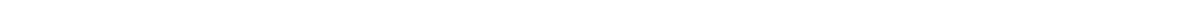
Fig. 4 Potent NLR-stimulating bacteria in the upper airway and intestine regulate lung immunity through GM-CSF signaling. a S . pneumoniae lung burden 12 h post-intranasal inoculation. Indicated groups were orally inoculated with TLR ligands (LPS 50 μ g and P3C 50 μ g) or NLR ligands (MDP 50 μ g and Mur N AcTriDAP 50 μ μ g) 48 and 24 h prior to lung infection. Antibody treatment was as described in Fig. 1m. Statisitcal comparisons were by Kruskal – Wallis test with Dunn ’ s test ( a ). b , c NOD2-dependent SEAP production by HEK293 cells 30 h post-stimulation with individual members of the microbiota ( b ), or bacterial consortia at an MOI of 1:10 ( c ). Values are from 7 to 16 biological replicates and error bars are s.d. ( b , c ). d , e S . pneumoniae ( d ) and K . pneumoniae ( e ) lung burden 12 h post-intranasal inoculation. Mice were orally inoculated with indicated bacterial consortia (~5 × 10 8 CFU) 48 and 24 h prior to intranasal infection. f GM-CSF levels in lung tissue 12 h post-inoculation with K . pneumoniae , data are from n = 5 – 8 mice/group and error bars are s.d. g 16 s rRNA gene copies in feces 3 days after oral inoculation with indicated consortia. h S . pneumoniae lung burden 12 h post-inoculation in outbred Swiss germ-free mice, and Swiss mice with a microbiota. Indicated groups were orally inoculated with bacterial consortia (10 8 CFU) 72 h prior to S . pneumoniae infection. i S . pneumoniae lung burden 12 h post-intranasal inoculation. Indicated groups of mice received the complete microbiota as described